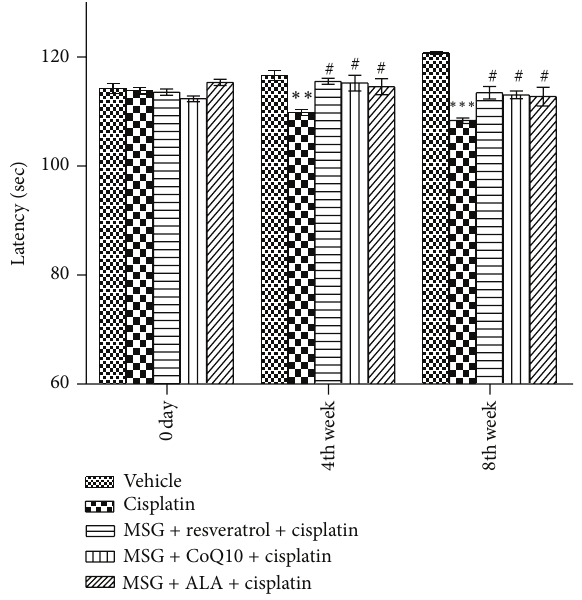
Figure 5: Effect of chronic treatment with combination of MSG and resveratrol/ALA/Co Q10 on motor coordination in cisplatin treated rats. ∗∗ ( 𝑃 < 0.01 ), ∗∗∗ ( 𝑃 < 0.001 ) versus control group, # ( 𝑃 < 0.05 ), versus cisplatin treated group.